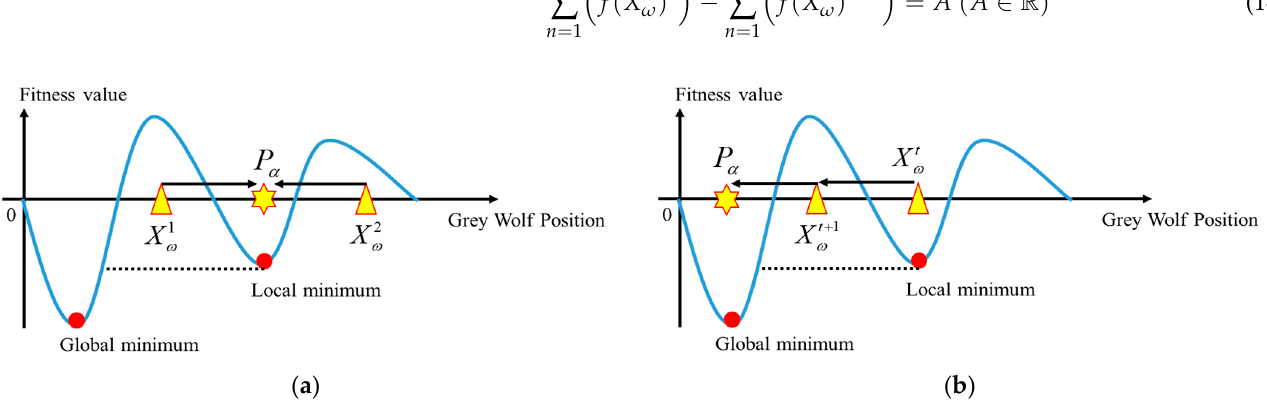
Figure 1. The hunting mechanism of GWO in one ‐ dimensional minimization. ( a ) 𝑃 𝛼 falls into a local optimum; and ( b ) 𝑃 𝛼 reaches the global optimum.